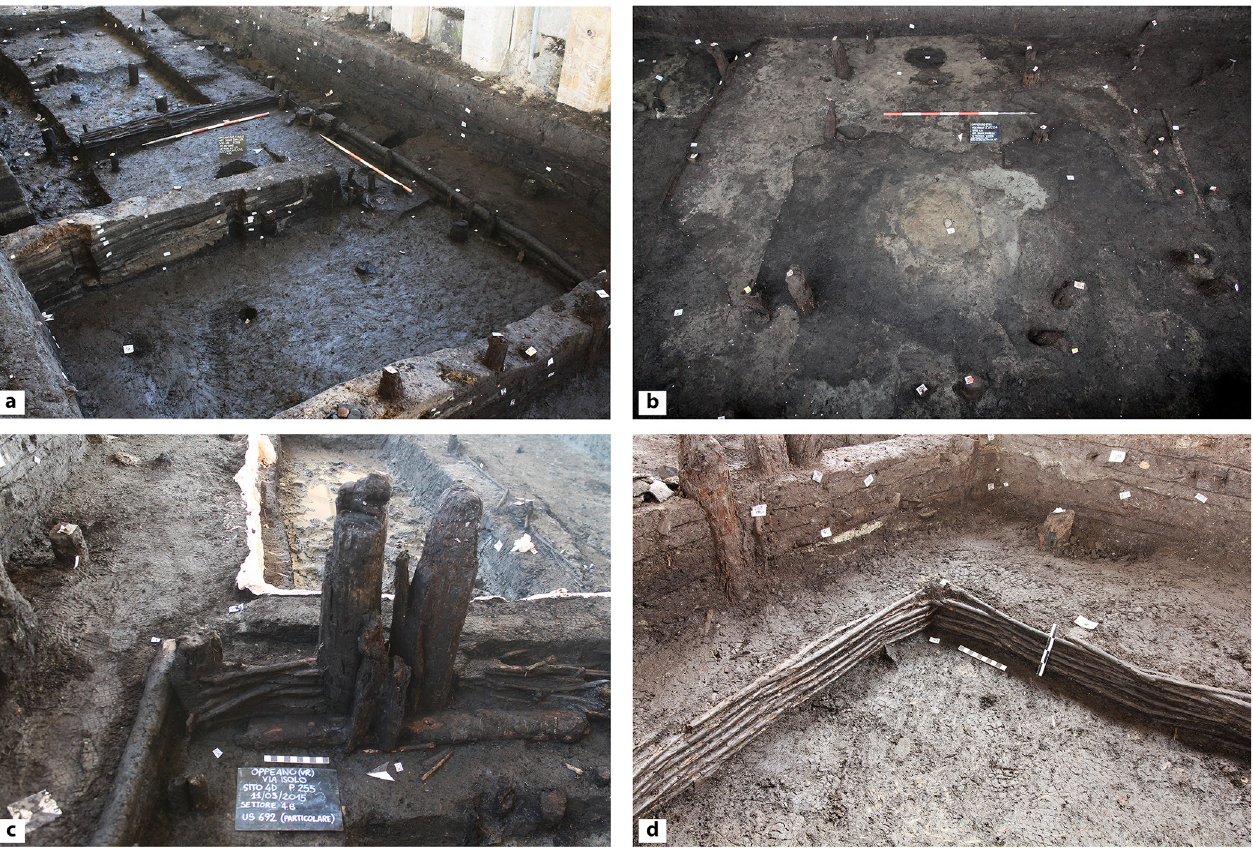
Fig 4. Field photographs. (a) general view of structure E, showing the walls built using different techniques and the internal stratification; (b) general view of structure A, characterized by two parallel rows of vertical posts, a central hearth, and a well-preserved sandy-clay floor; (c) detail of structure F walls, built using horizontally lying timber and branches woven around vertical posts (‘wattle and post’); (d) detail of a corner of structure F, showing walls built using the wattle and post